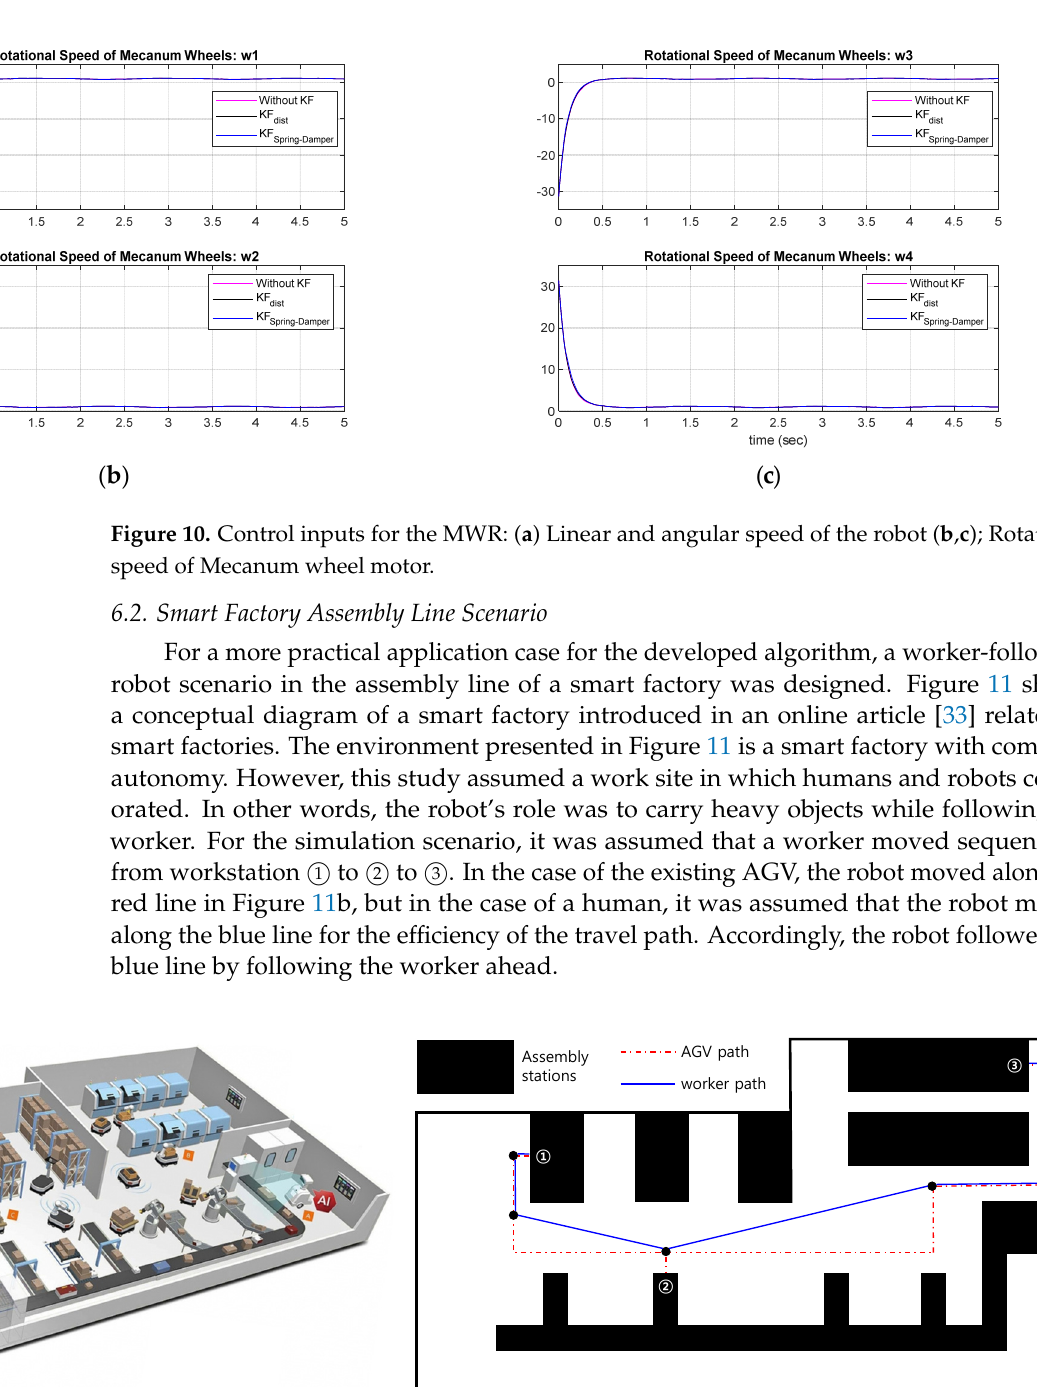
( d ) Figure 12. Worker-following performance: ( a ) 2D plane worker-following performance ( b ) Longi- tudinal direction performance ( c ) Lateral direction performance ( d ) Target tracking performance (relative distance). 7. Conclusions Industrial sites are in a transitional stage of transforming into fully autonomous sys- tems using robotic technology. However, to protect the labor rights and income of field